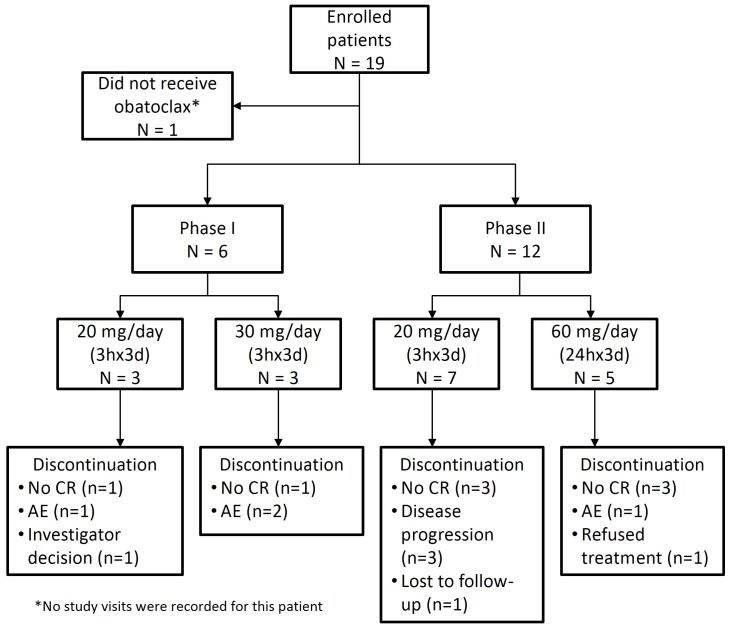
Patient disposition. AE, adverse event; CR, complete response.